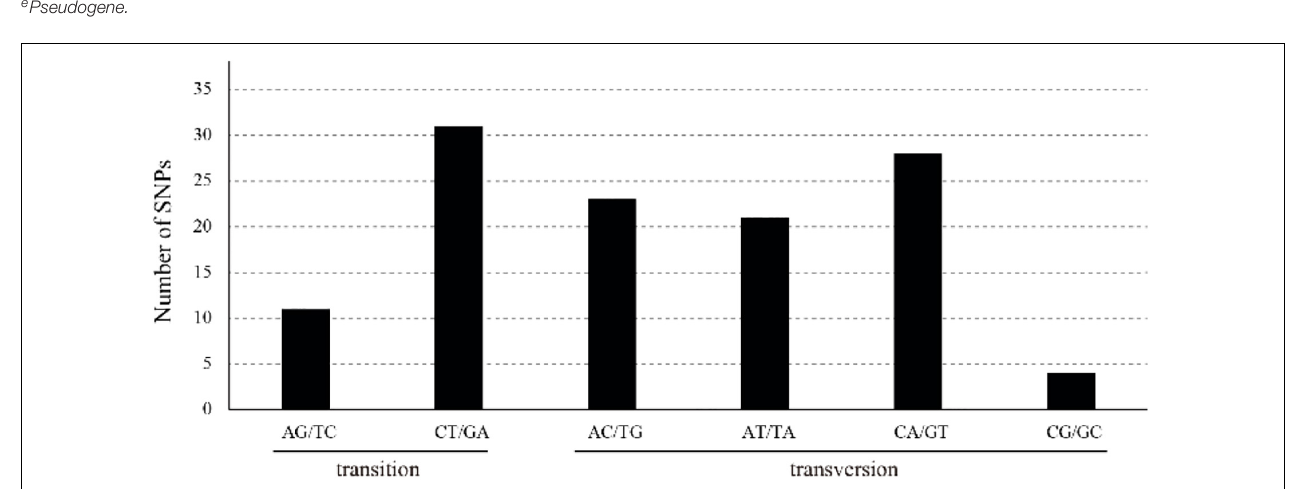
FIGURE 2 | Pattern diagram of single base substitution (SNP) in Z. jujuba chloroplast